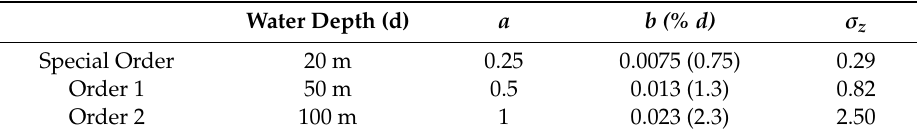
Table 5. Parameters used to estimate vertical uncertainty using IHO [33] uncertainty guidelines for various